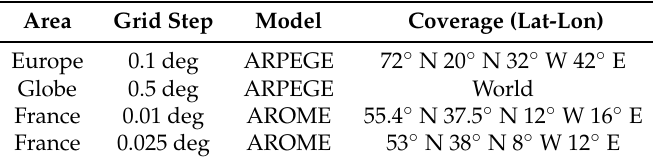
Table 2. Weather data downloadable from Meteo